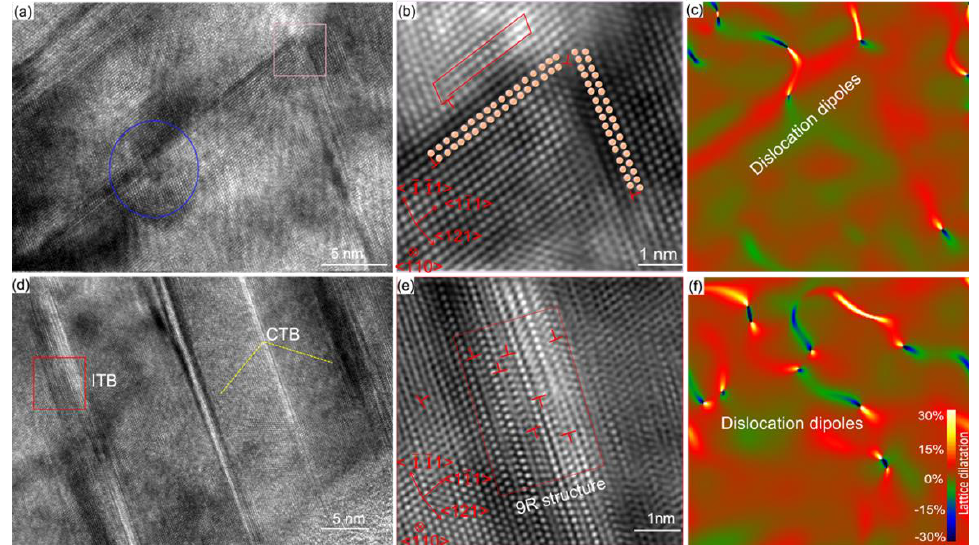
Figure 7. HR-TEM images close to an MCS. ( a ) HR-TEM of the ‘V’-shaped configuration of SF. The pink and blue area indicate Lomer–Cottrell locks and APB. ( b ) A close-up IFFT of the pink box in ( a , c ) GPA map with (200) frequency showing dislocation structure. ( d ) HR-TEM images of twins. The yellow and red box indicate the CTB and ITB respectively. ( e ) The IFFT images of ITB. ( f ) The corresponding GPA map.